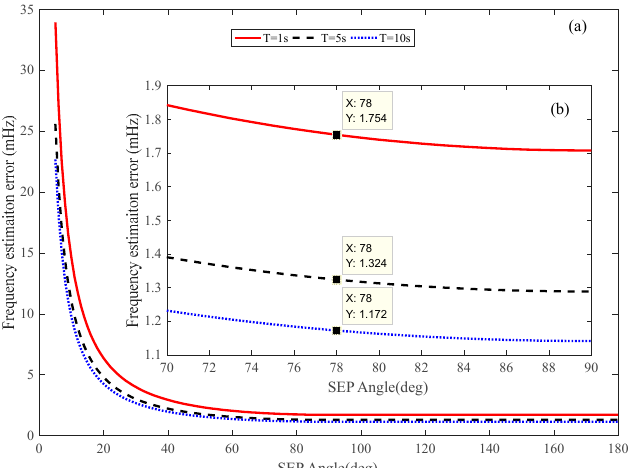
Figure 10. The frequency estimation error caused by phase scintillation (two-way and tree-way mode, X band). ( a ) full range of SEP angle; ( b ) enlarged view of SEP angle.